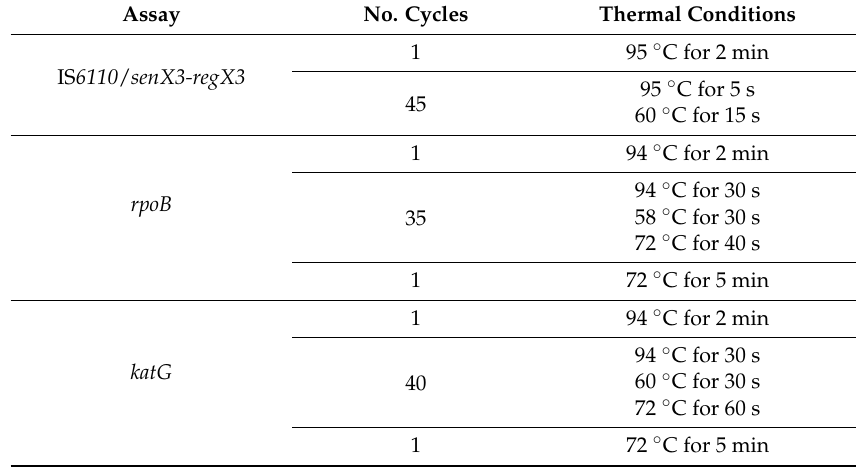
Table 1. Cycling parameters for the real-time PCR (qPCR) and conventional PCR ( rpoB and katG ) assays. Assay No. Cycles Thermal Conditions IS 6110 /